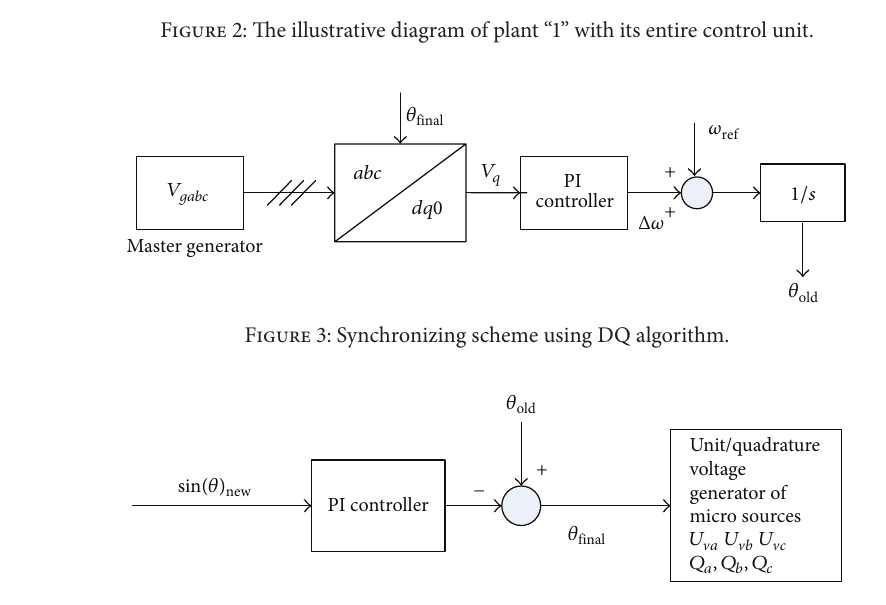
Figure 4: Generation of unit vector using synchronizing angle ( 𝜃 final